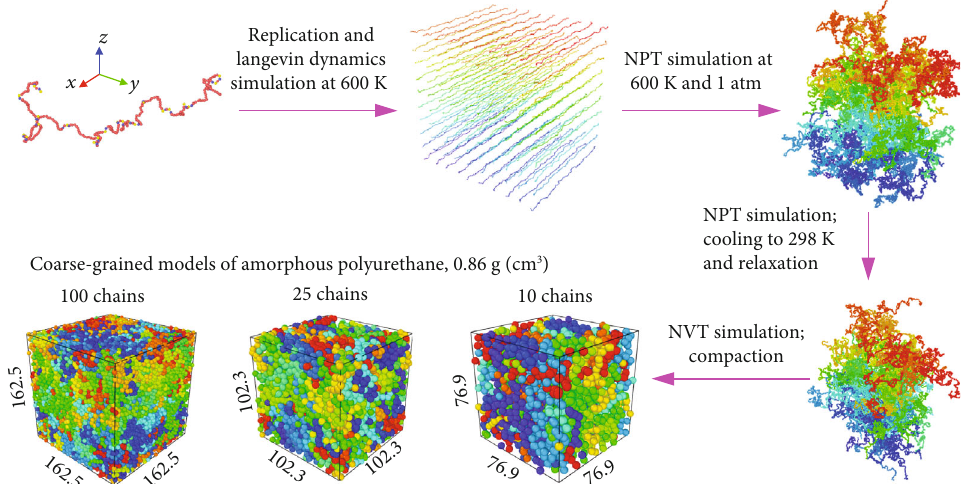
Figure 3: Construction of the coarse-grained model of amorphous PU matrix. The di ff erent molecular chains were painted with di ff erent colors, and the unit of side length is